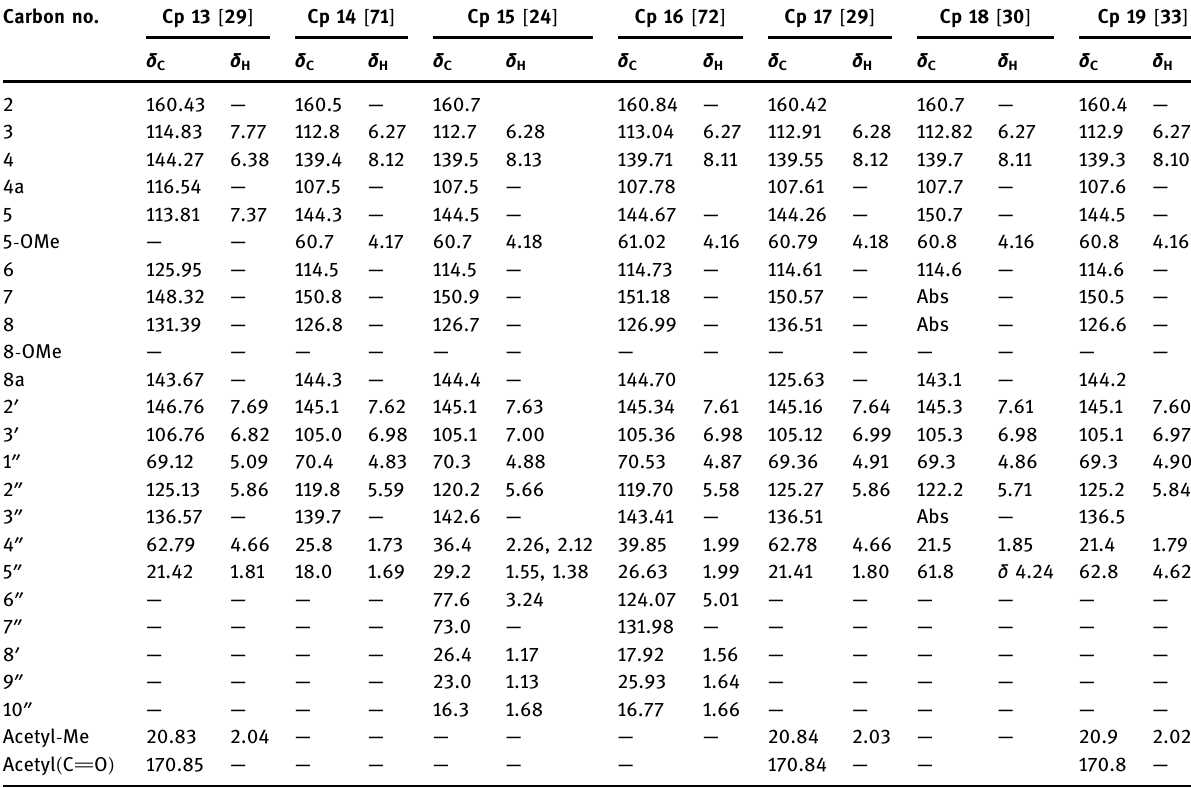
Table 5: 13 C and 1 H NMR chemical shift data ( δ , ppm ) of furanocoumarins isolated from genus Casimiroa Carbon no.